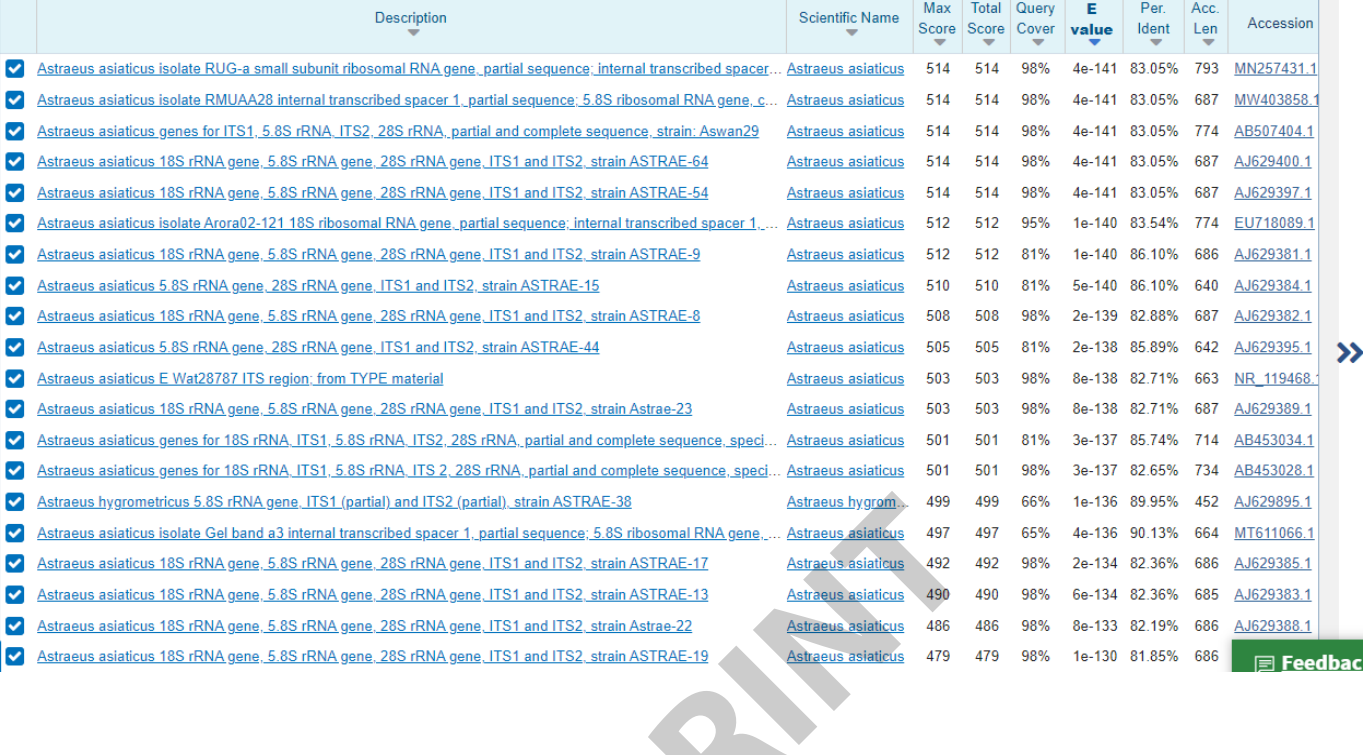
Figure 5 BLAST result of Astraeus sp . with the highest sequence similarity of Astraeus